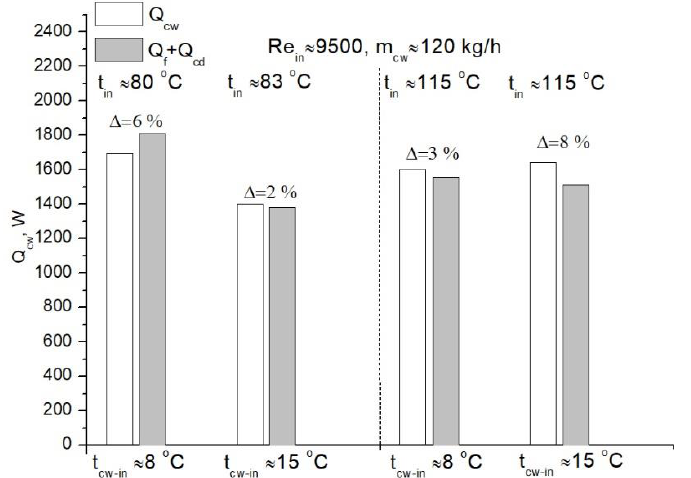
Figure 16. Comparison of heat balance for Re in ≈ 9500 at different flue gas and cooling water inlet temperatures.